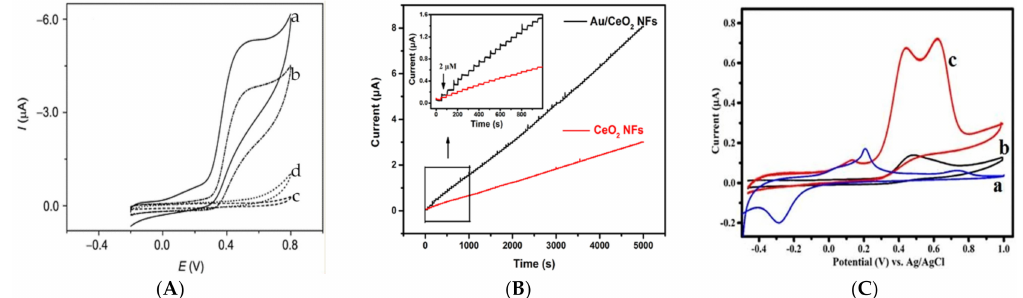
Figure 5. ( A ) Cyclic voltammograms of 0.5 mmol/L (a, c and d) and 0.2 mmol/L (b) cysteine at an Au/Nafion/GCE (a, b), Nafion/GCE (c) and bare GCE (d), Scan rate: 20 mV/s in PBS (pH 2.0) [65]. ( B ) Amperometric response curves of the CeO 2 NFs and Au/CeO 2 NFs modified SPCEs in 0.01 M PBS (pH 7.4) in the concentration range of 2.0–200 µ M (applied potential 0.7 V) [102]. ( C ) Cyclic voltammograms of (a) Ag/ITO, (b) Poly dopamine /ITO and (c) Ag-Poly dopamine/ITO in 0.1